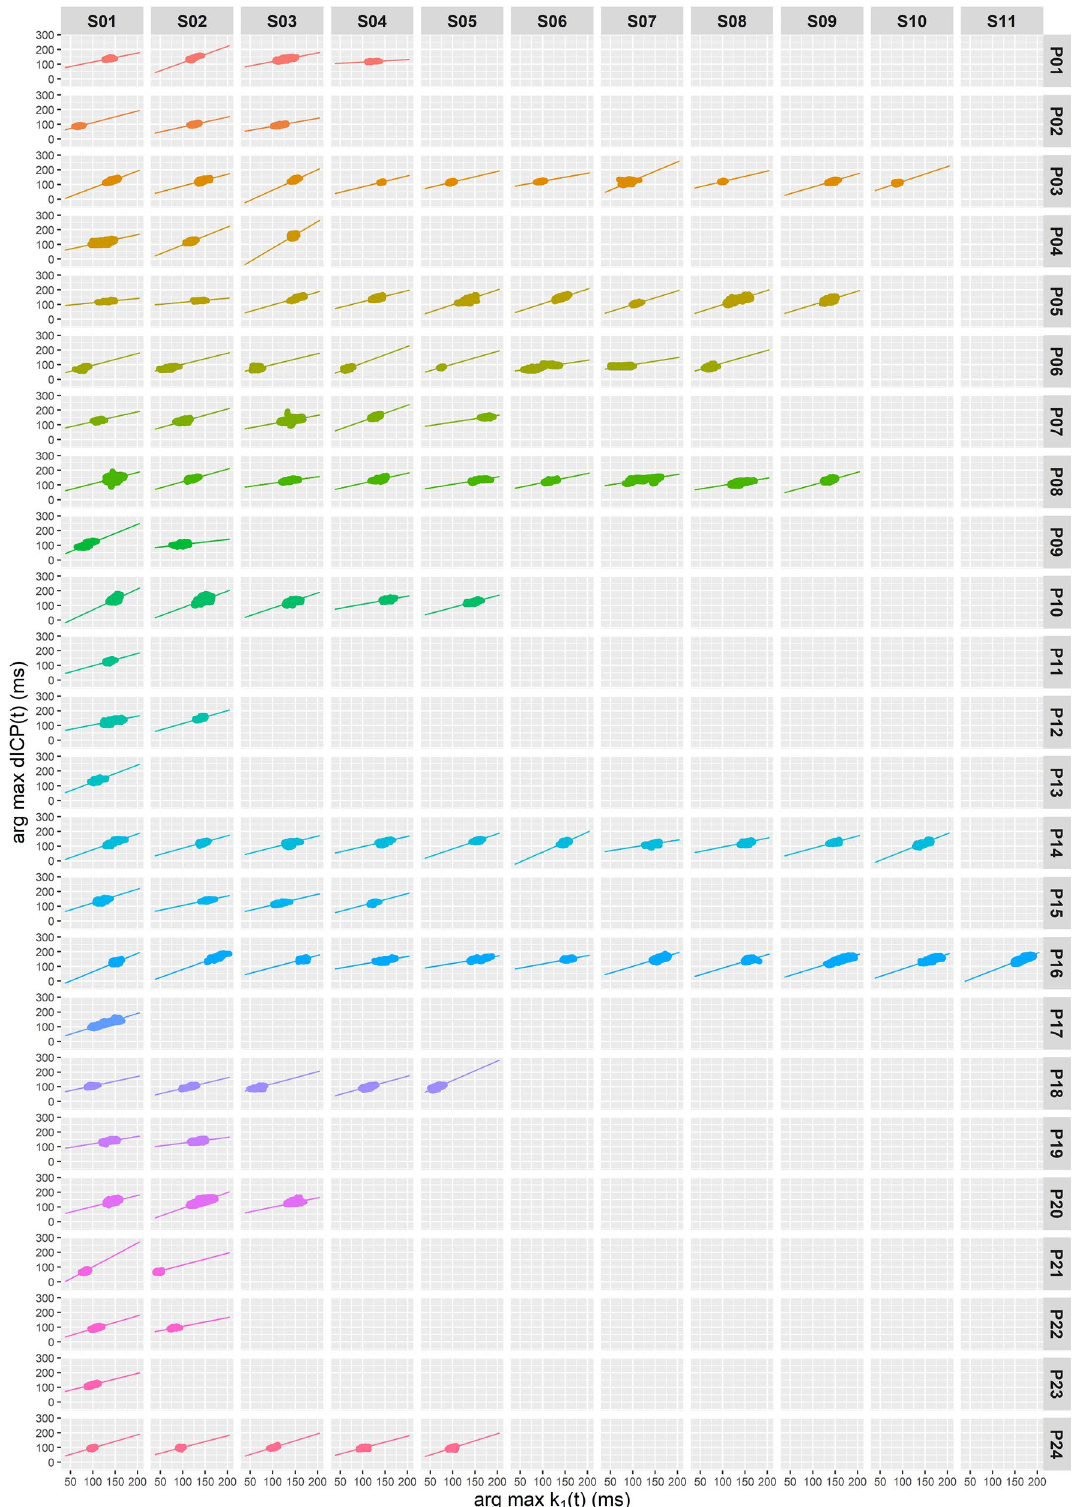
Figure 4. Correlation analysis for individual segments. Correlation between the selected k 1 (t) and the first dICP maximum (ms) drawn separately for all 108 segments. The figure was generated using R 4.0.0 (R Core Team (2020). R: A language and environment for statistical computing. R Foundation for Statistical Computing, Vienna, Austria. URL https:// www.R- proje ct. org/.) with ggplot2 3.3.2 (H. Wickham. ggplot2: Elegant Graphics for Data Analysis. Springer-Verlag New York,